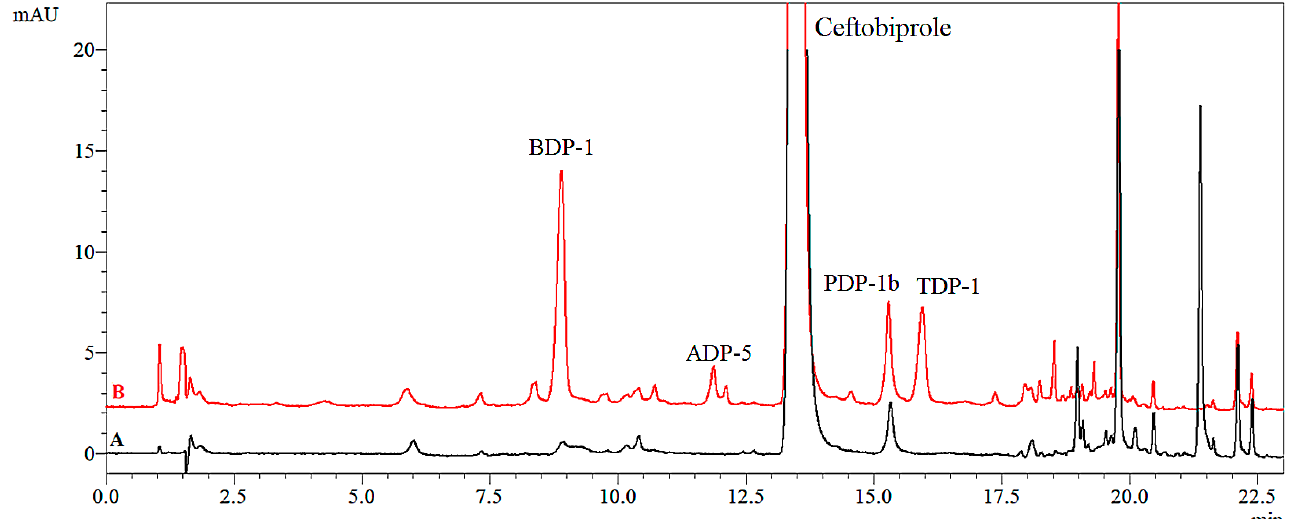
Figure 10. Overlaid chromatograms obtained from the separation of 1 mg/mL ceftobiprole solution by thermolysis in 10% DMSO: ( A ) at time 0; ( B ) after 270 min at 70 °C.